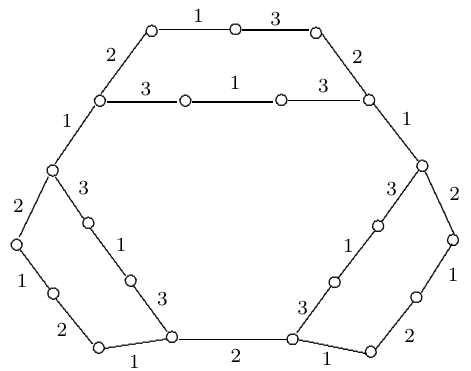
Figure 1: A 2-connected graph G with proper connection number 3